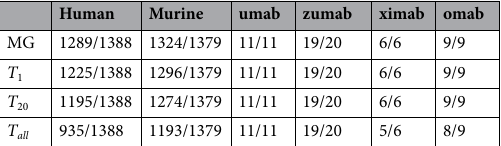
Table 1. Fraction of correct predictions. Fraction of correct predictions for the test and therapeutic databases, using the threshold obtained as specified in Methods, to distinguish between human and murine